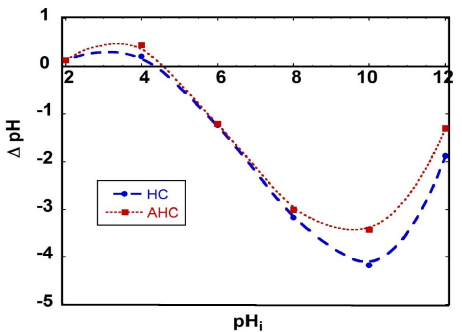
Figure 4. Δ pH as a function of HC and AHC with a solid-to-solution ratio of 1 g/L, stirring at 350 rpm for 24 h and background electrolyte 0.1 NaCl. 3.5. Equilibrium Adsorption of Methylene Blue Dye Figure 5a shows the effect of the initial concentration of MB dye (C i ) on the equilib- rium adsorption capacity (q e ) after 24 h under continuous stirring to reach equilibrium. The HC sample has a q e of 2.58, 6.63, 25.40 and 49.80 mg/g, while the AHC sample has a q e of 1.88, 3.53, 10.99 and 11.77 mg/g when the initial concentrations of MB dye were 5, 10, 50 and 100 mg/L, respectively. The HC sample shows higher equilibrium adsorption ca- pacities than the AHC sample. The q e of MB dye on the HC sample increases as the initial concentration increases. On the other hand, the q e of MB dye on the AHC sample increases quickly at a lower initial concentration, and then the q e slows at higher initial concentra- tions. As the initial concentration of MB dye increases, the diffusion of MB molecules in- creases as well. Then, the adsorption process would continue until the accessible sites on the adsorbent surface are used, resulting in a higher q e . Figure 5b shows the effect of increasing the initial concentration of MB dye (C i ) on the removal efficiency (R%). R% values were 91%, 87%, 83% and 82% for the HC sample and 82%, 86%, 45% and 23% for the AHC sample when the initial concentrations of MB were 5, 10, 50 and 100 mg/L, respectively. In both samples, as the initial concentration of MB dye increases, the removal efficiency decreases, which may be related to the saturation of the adsorbent surface with MB dye. In addition, the removal efficiency observed by the HC sample is always higher than the AHC sample.